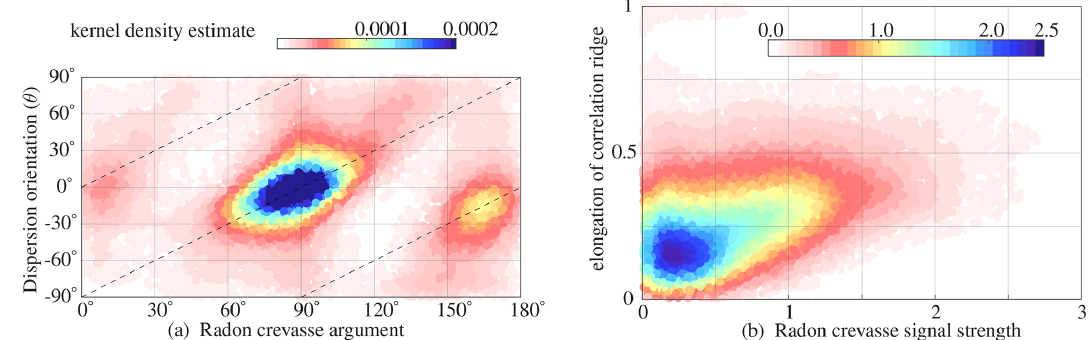
Figure 8. Probability density plots of results for Sermeq Kujalleq of correlation peak versus crevasse orientation (Figs. 2 and 3a) and asymmetry of the correlation peak and versus crevasse strength (Figs. 2 and 4a).